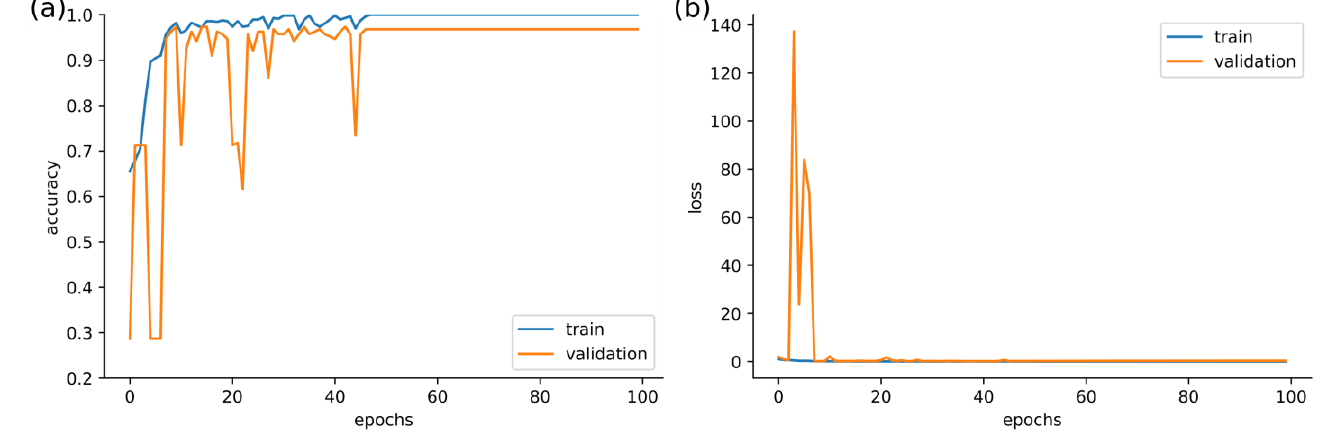
Figure 3. Accuracy and loss of the training and validation set from the original dataset. Results are presented for genus level data. Parameters for the training set are visualized as a blue line and for the validation set as an orange line. The values were tracked with keras [47]. ( a ) Accuracy of the training and validation set during the training of 100 epochs. ( b ) Training and validation set loss during the training of 100 epochs.